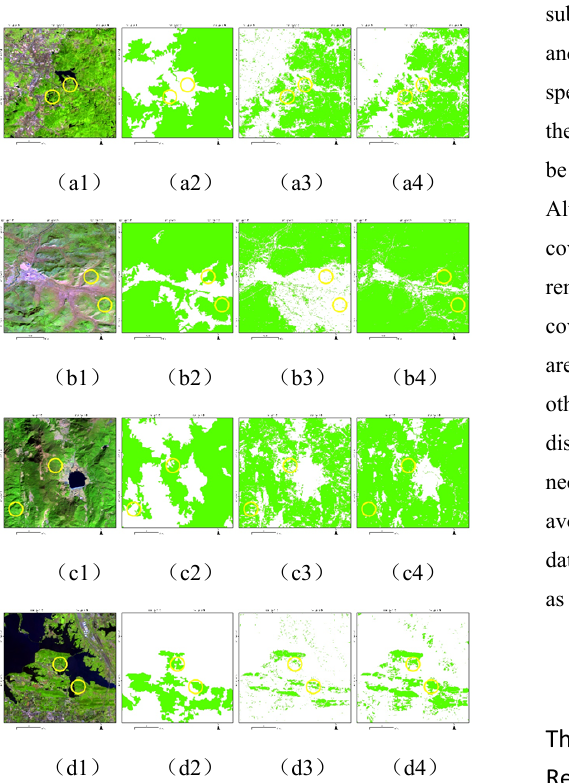
Figure 5. Local comparision of forest detection in different partitions